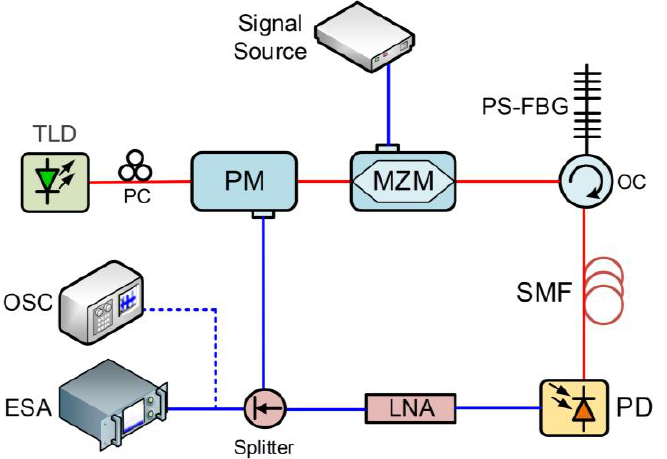
Figure 1. Schematic diagram of the proposed microwave-signals-generation system based on actively mode-locked OEO. TLD: tunable laser diode, PM: phase modulator, MZM: Mach–Zehnder modulator, EDFA: erbium-doped fiber amplifier, SMF: single-mode fiber, PC: polarization controller, PS-FBG: phase-shifted fiber Bragg grating, PD: photodetector, LNA: low-noise amplifier, ESA: electrical spectrum analyzer, OSC: oscilloscope.